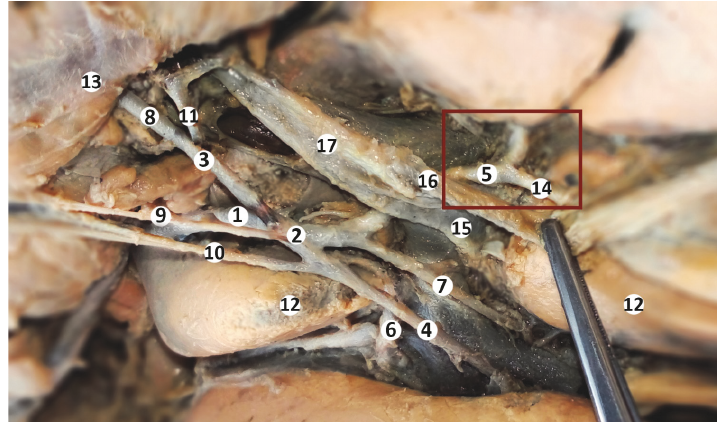
Figure 4: Cystic artery. Macrospecimen (female, 63 years old). 1: common hepatic artery, 2: proper hepatic artery, 3: gastroduodenal artery, 4: left hepatic artery, 5: right hepatic artery, 6: accessory left hepatic artery, 7: intermediate hepatic artery, 8: superior posterior pancreaticoduodenal artery, 9: superior duodenal artery, 10: right gastric artery, 11: right gastroepiploic artery, 12: liver, 13: duodenum, 14: cystic artery, 15: hepatic duct, 16: cystic duct, and 17: common bile duct.